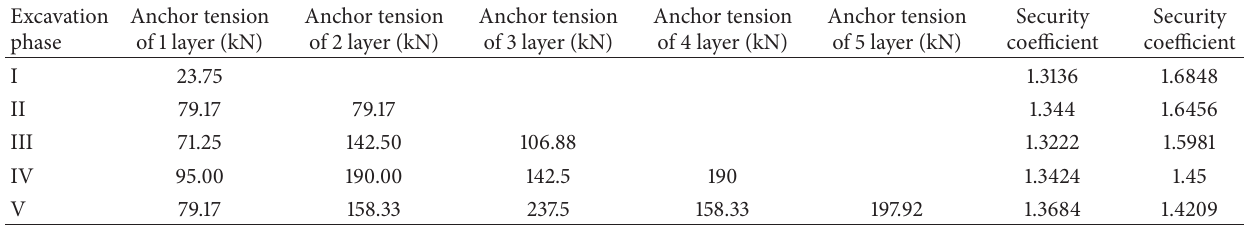
Table 3: Anchor tension of slope excavation stages.